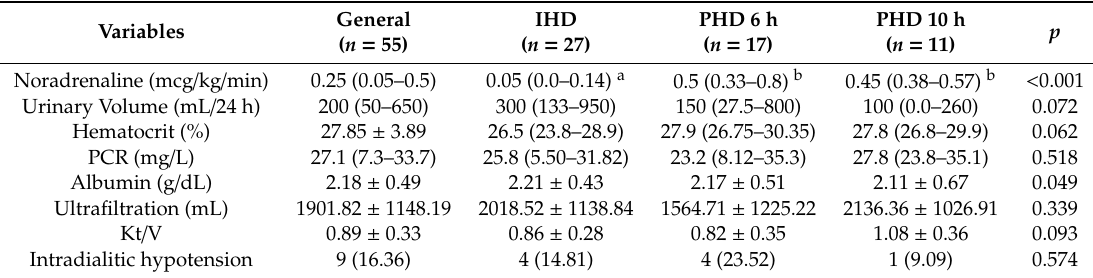
Table 3. Laboratory and dialytic characteristics of the general population and of the groups according to di ff erent dialytic treatments on the day of the